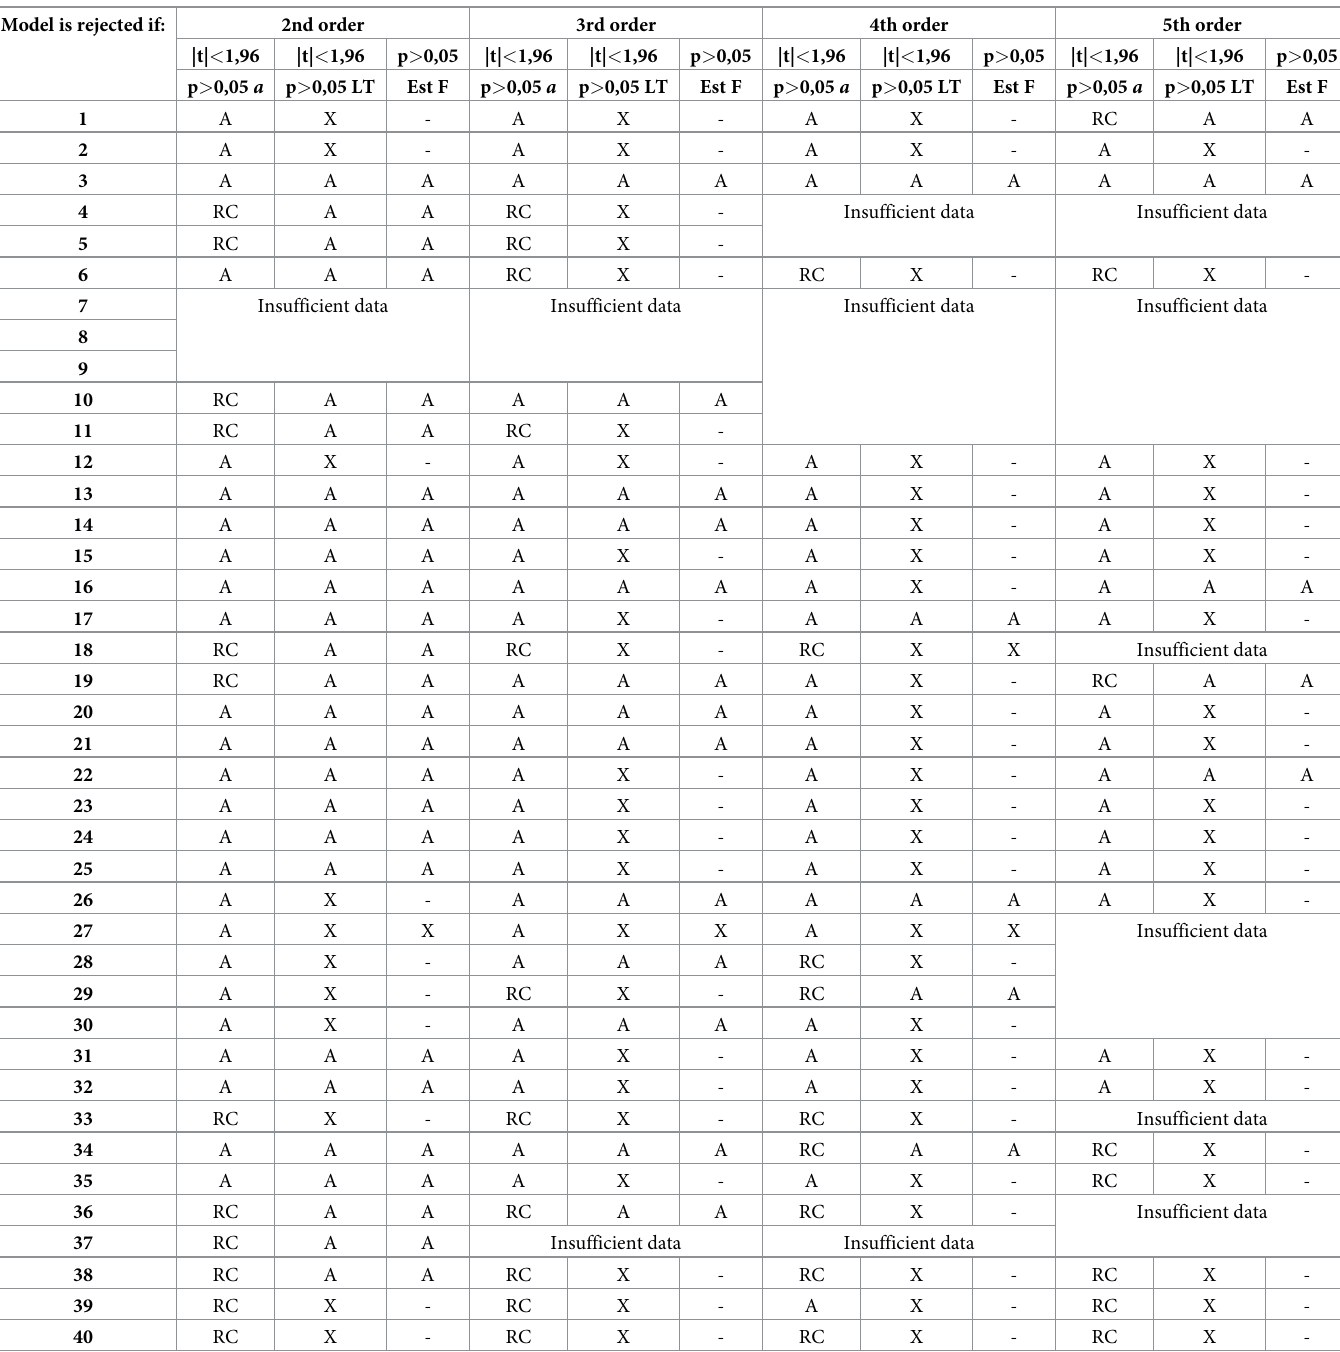
Table 4. Evaluation of the p-value of the intercept, last term, and F-statistic of the data sets. Model is rejected